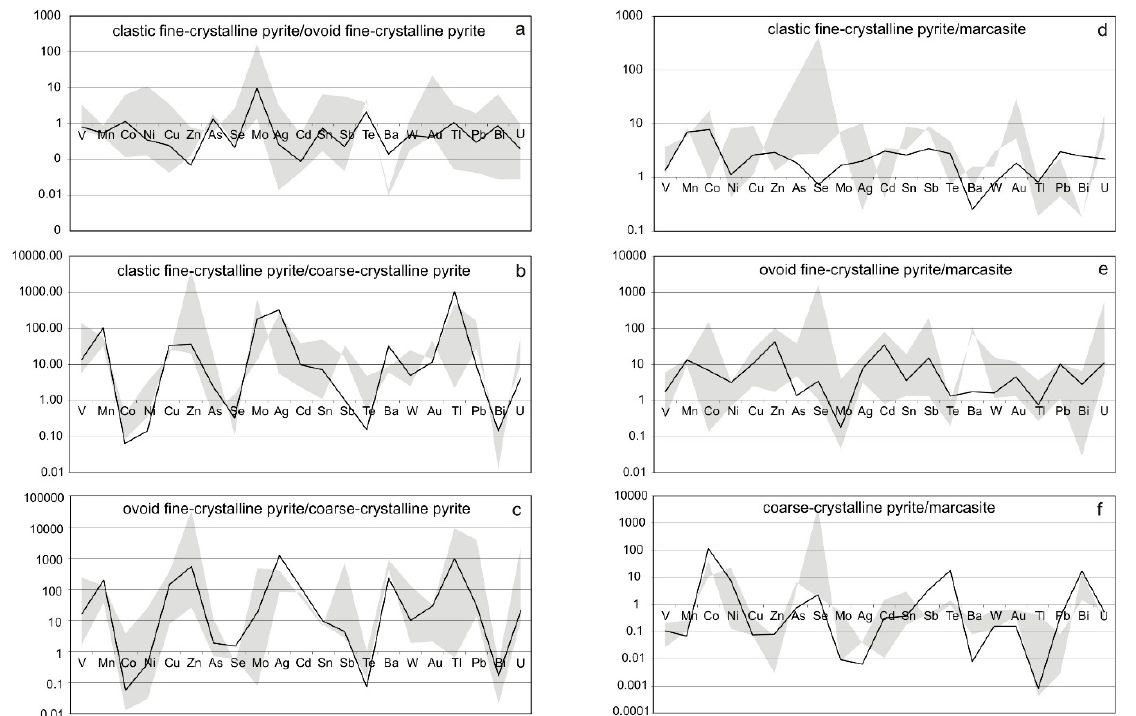
Figure 10. Ratios of average trace element contents for pairs of major sulfide types: ( a ) clastic fine ‐ crystalline pyrite/ovoid fine ‐ crystalline pyrite; ( b ) clastic fine ‐ crystalline pyrite/coarse ‐ crystalline pyrite; ( c ) ovoid fine ‐ crystalline pyrite/coarse ‐ crystalline pyrite; ( d ) clastic fine ‐ crystalline pyrite/marcasite; ( e ) ovoid fine ‐ crystalline pyrite; ( f ) coarse ‐ crystalline pyrite/marcasite. The shaded area corresponds to variations in maximum and minimum ratios of trace element contents.